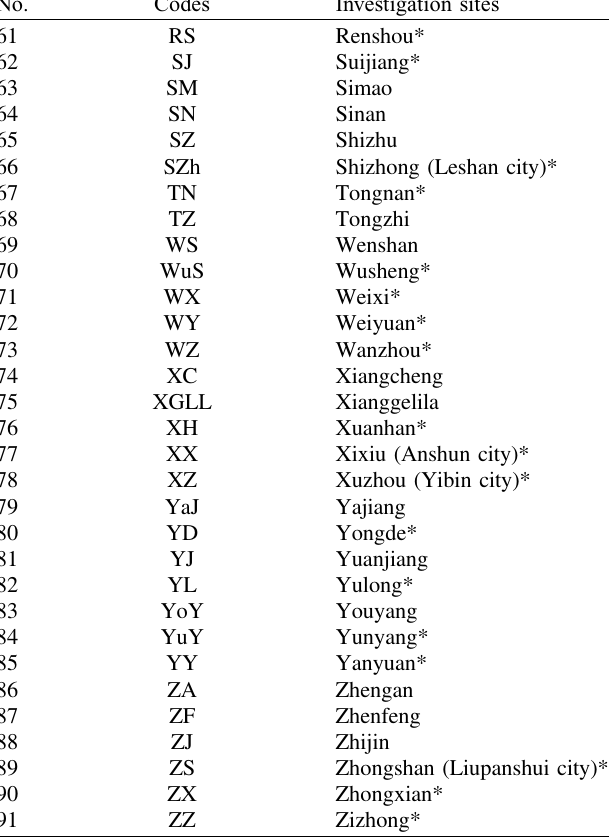
Table 1. A total of 91 investigation sites (counties) in Southwest China (2001 –